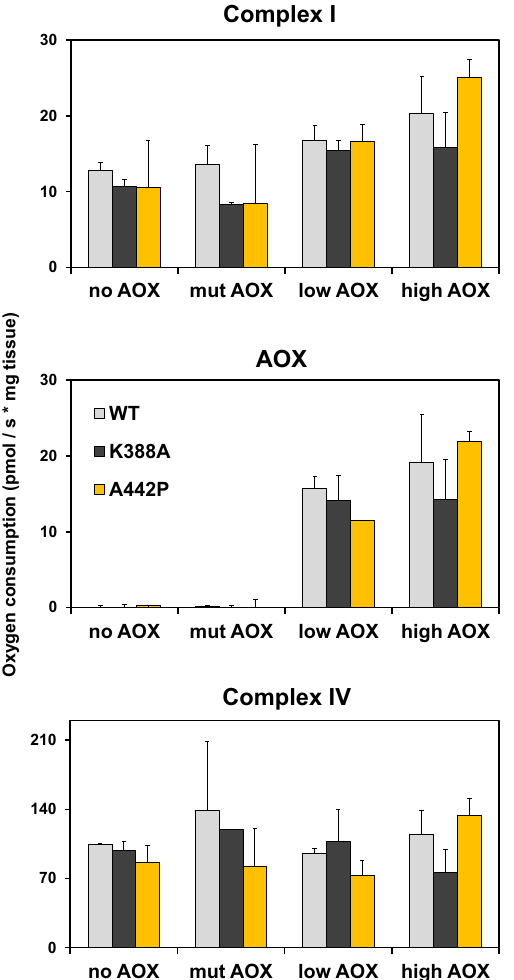
Figure 3. Mitochondrial respiration is not affected by overexpression of Twinkle nor AOX. Oxygen consumption was measured as described in the Methods in samples expressing the indicated AOX and Twinkle variants ( UAS-AOX ; UAS-Twinkle X daGAL4 ). Respiration linked to complex I substrate oxidation ( upper panel ) was calculated as the mean oxygen consumption after addition of pyruvate, proline, malate and ADP, followed by inhibition with antimycin A and rotenone. AOX activity (antimycin A-resistant respiration) was calculated as the mean oxygen consumption after addition of pyruvate, proline, malate, ADP and antimycin A, followed by inhibition with propyl-gallate and rotenone. Complex IV activity was calculated as the mean oxygen consumption after addition of TMPD and ascorbate, followed by inhibition with potassium cyanide. no AOX, mut AOX, low AOX and high AOX indicate respectively the constructs UAS-empty 2nd , UAS-mutAOX 2nd , UAS-wtAOX 8 . 1 21 and UAS-wtAOX F6 12 . No significant differences were found ( P > 0.05) according to one-way ANOVA, followed by the Tukey post-hoc